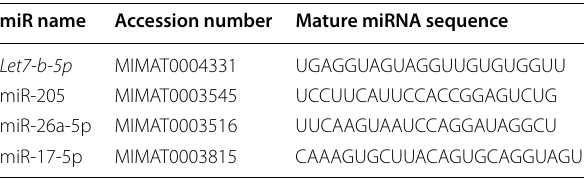
Table 2 List of miRNAs names, miRbase accession numbers, and their mature